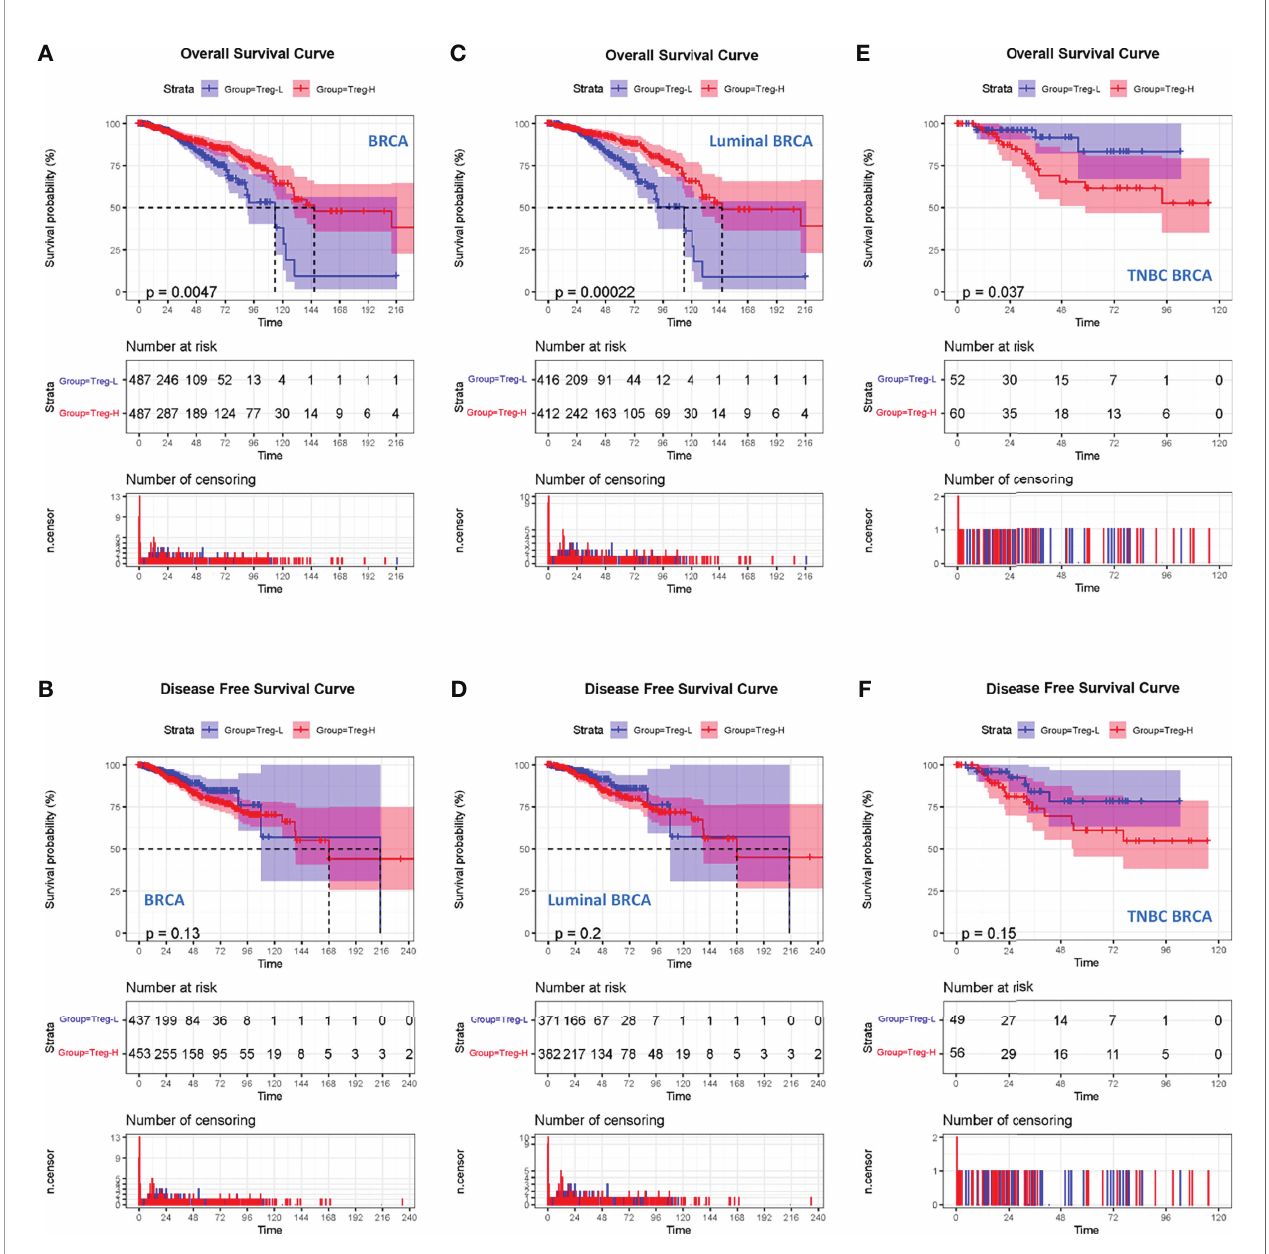
FIGURE 2 | High Treg expression is associated with a worse prognosis in TNBC. (A) Kaplan – Meier curves for the OS of breast cancer patients in TCGA database who were divided into Treg-H and Treg-L groups. (B) Kaplan – Meier curves for the DFS of breast cancer patients between the Treg-H and Treg-L groups. (C) Kaplan – Meier curves for the OS of the luminal subtype between the Treg-H and Treg-L groups. (D) Kaplan – Meier curves for the DFS of the luminal subtype between the Treg-H and Treg-L groups. (E) Kaplan – Meier curves for the OS of the TNBC subtype between the Treg-H and Treg-L groups. (F) Kaplan – Meier curves for the DFS of the TNBC subtype between the Treg-H and Treg-L